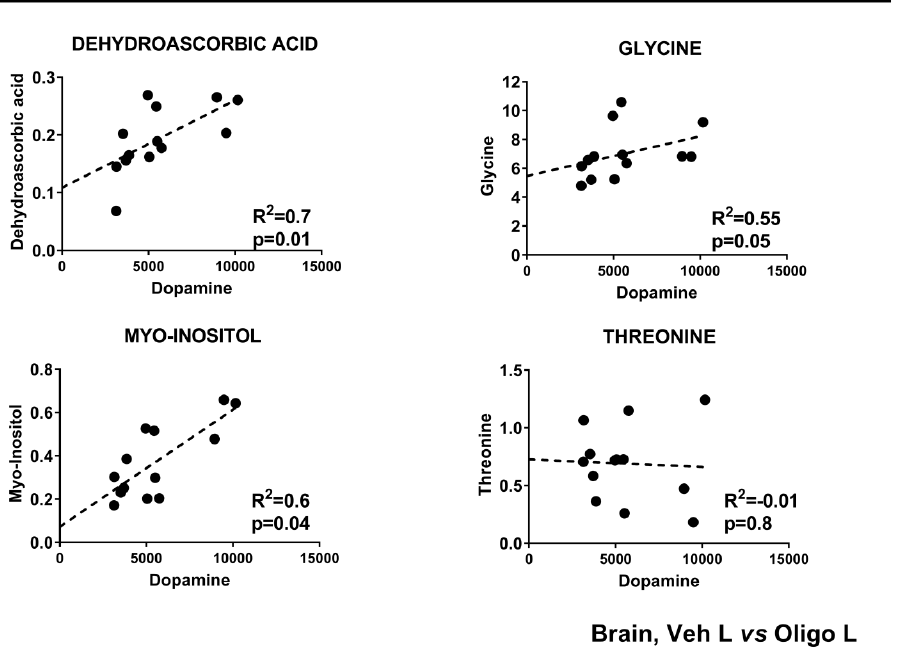
Figure 5. Spearman Correlation of striatal DA concentrations with the concentration of metabolites in the mesencephalon. p -value < 0.05.